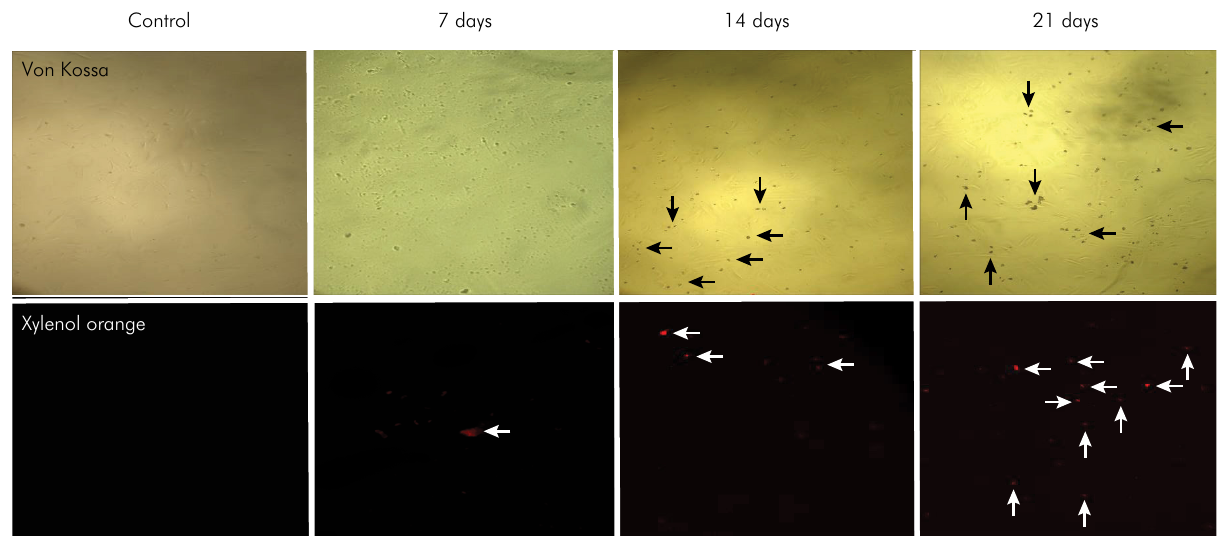
Figure 2. Representative illustration of the Von Kossa and xylenol orange assays at 7, 14, and 21 days after osteogenic induction. An increasing amount of mineral nodules is noted overtime